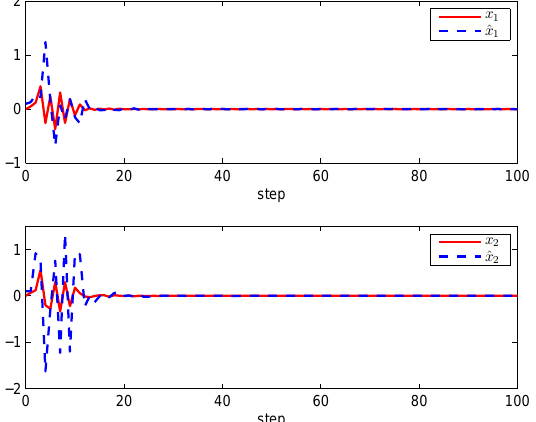
Figure 4: The output y ( k ) and the quantized output q ( y ( k